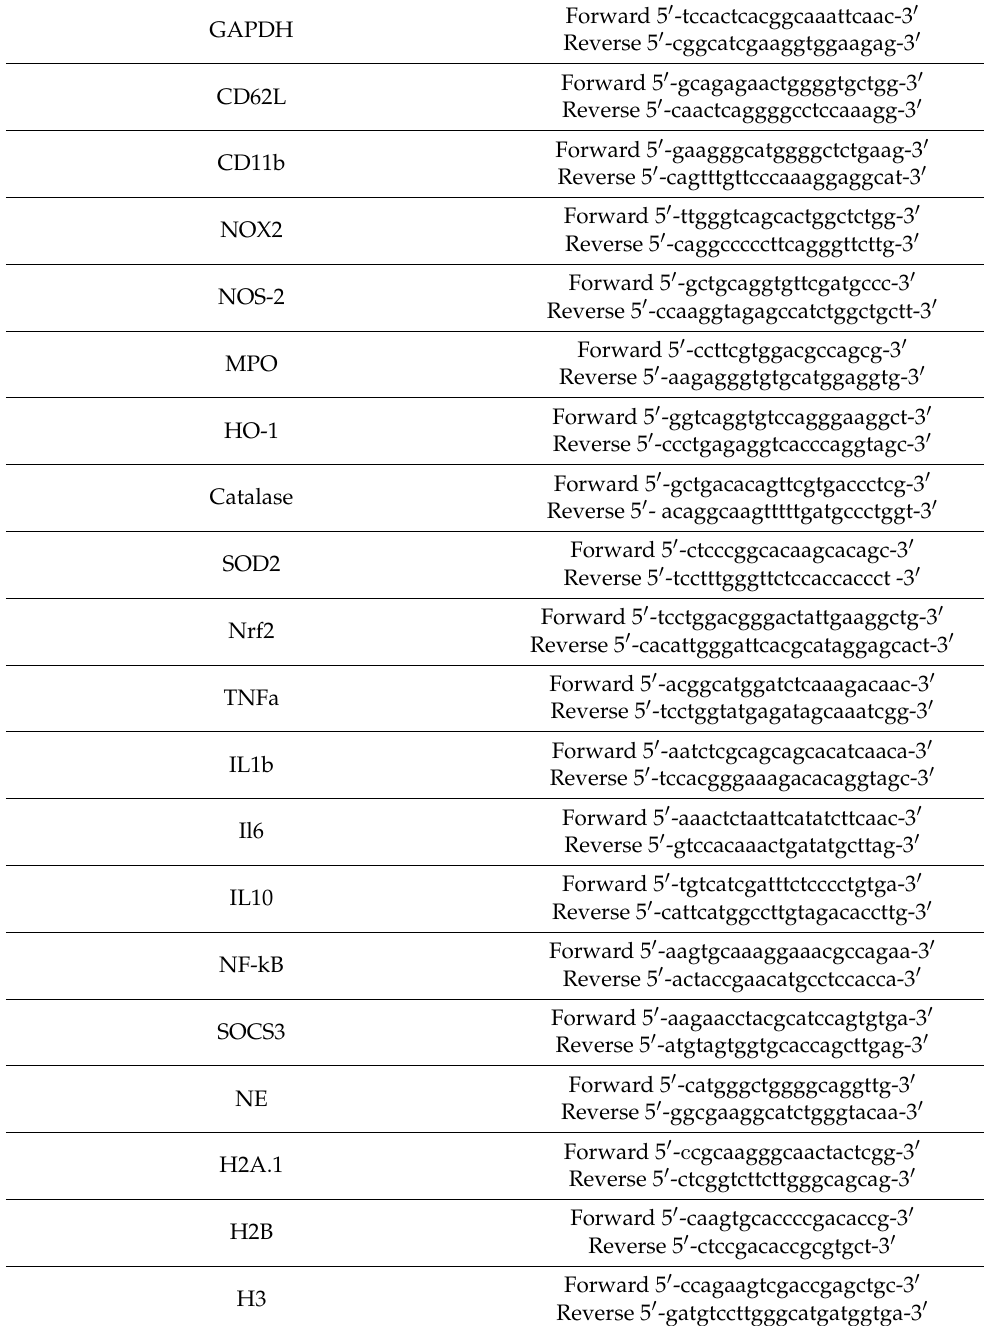
Table 1. Primer sequences for real-time polymerase chain reaction